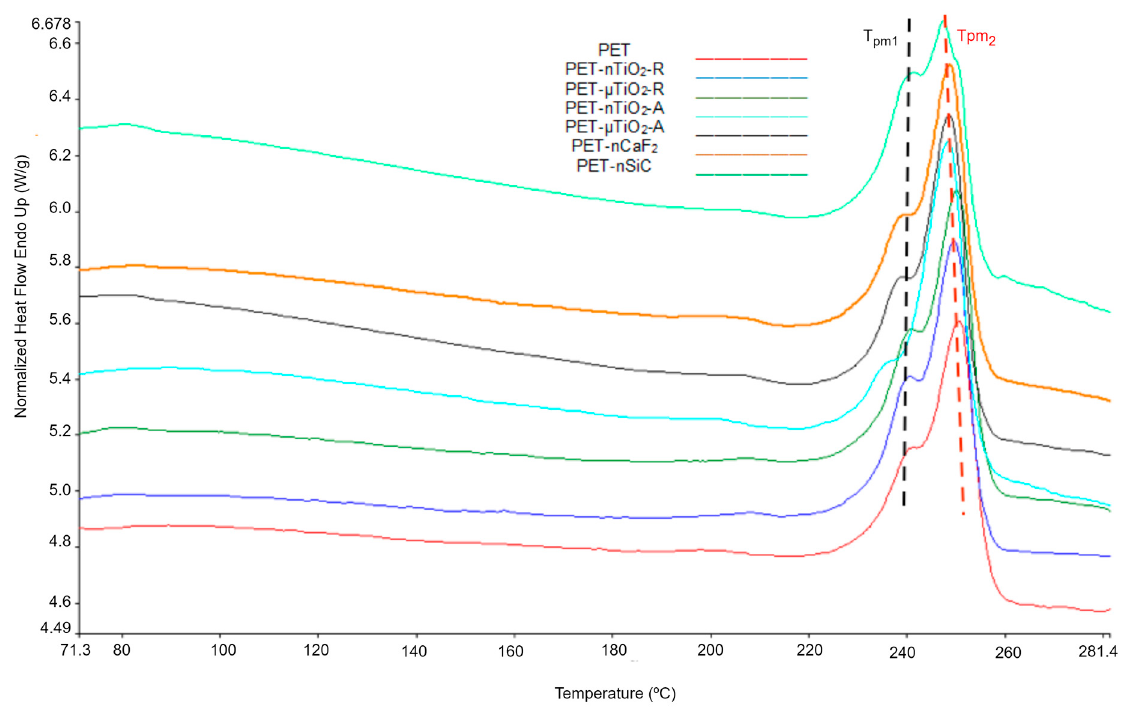
Figure 8. Thermograms of the second heating of the polymer blends after 170 days of